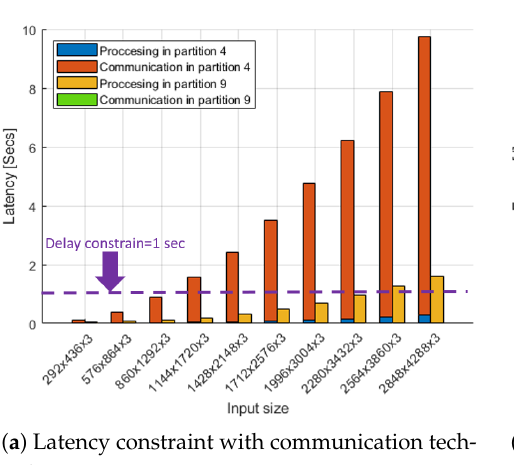
Figure 13. Contribution of the processing and communication components to the time and energy of partitions 4 and 9 depending on the image size.